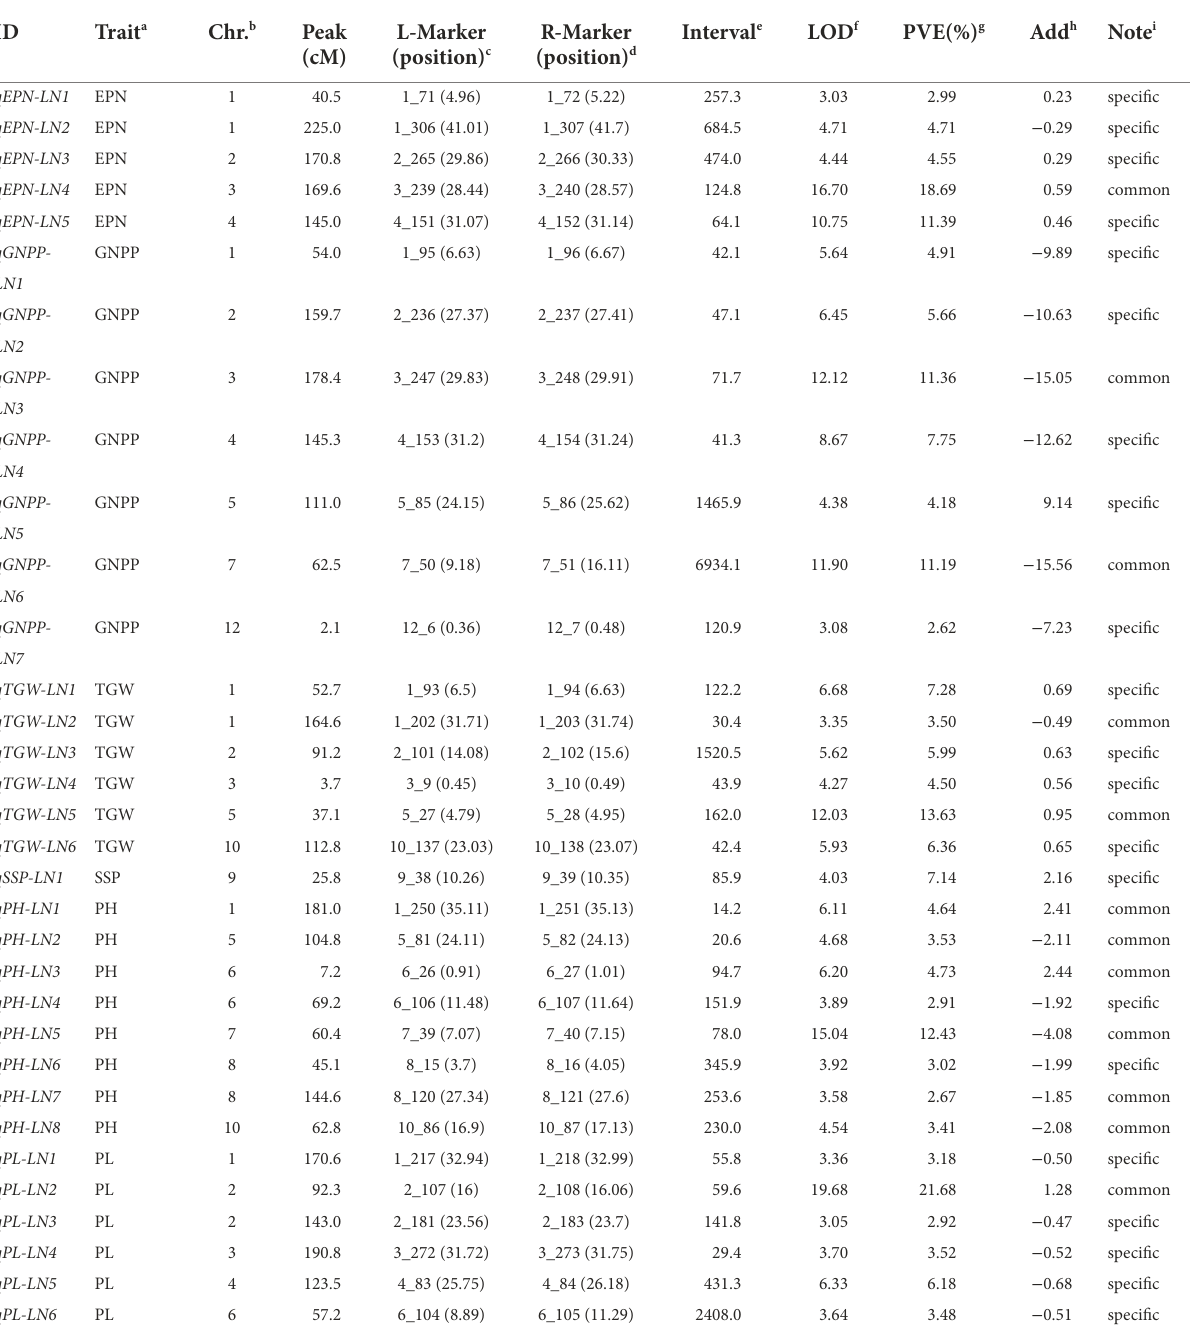
TABLE 2 QTLs associated with seven agronomic traits of the RIL population under LN